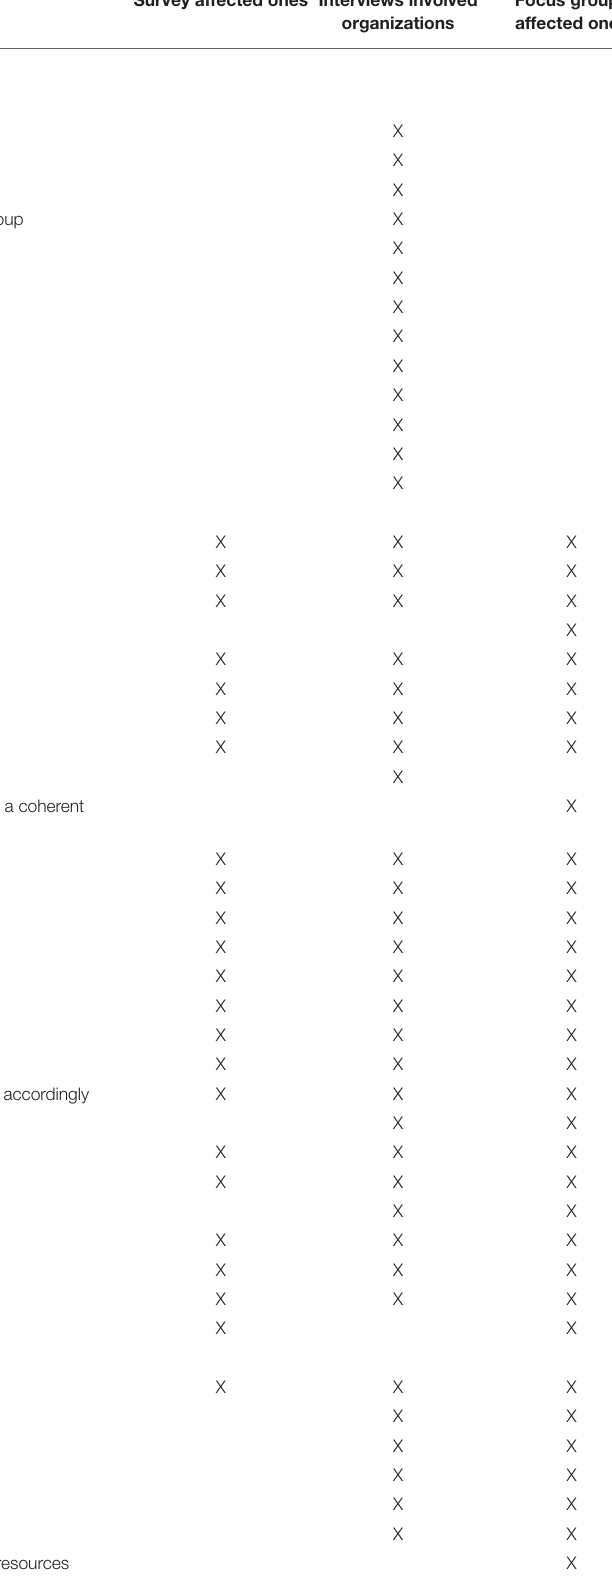
Focus groups organizations affected